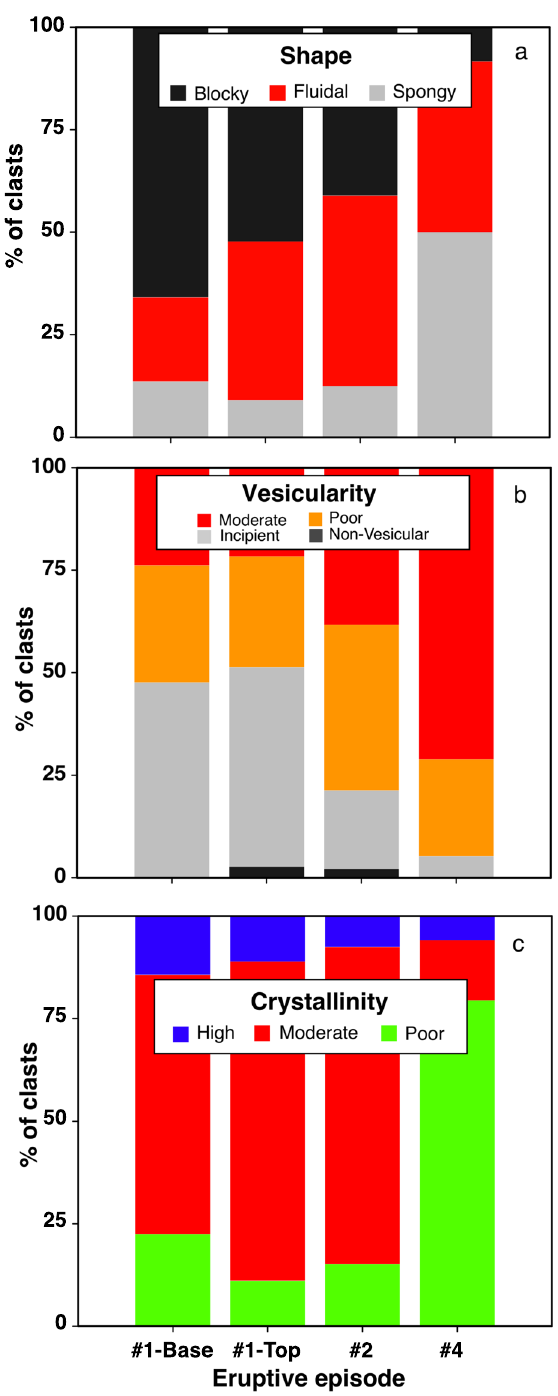
Figure 3. Variations in the morphological and textural parameters of the different eruptive